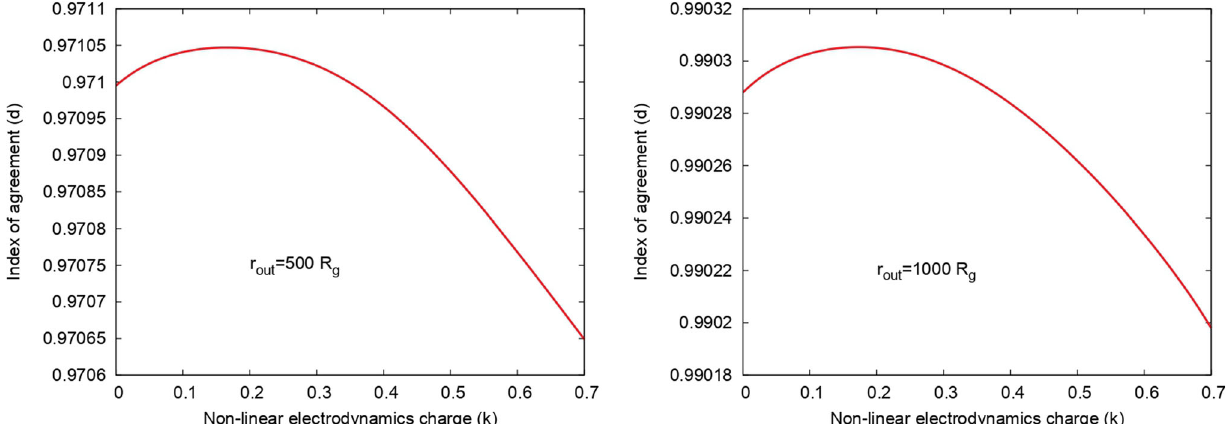
Fig. 5 The above figure plots the index agreement d with respect to the non-linear electrodynamics charge parameter k . The index of agree- ment computed with r out = 500 r g and r out = 1000 r g are shown in the